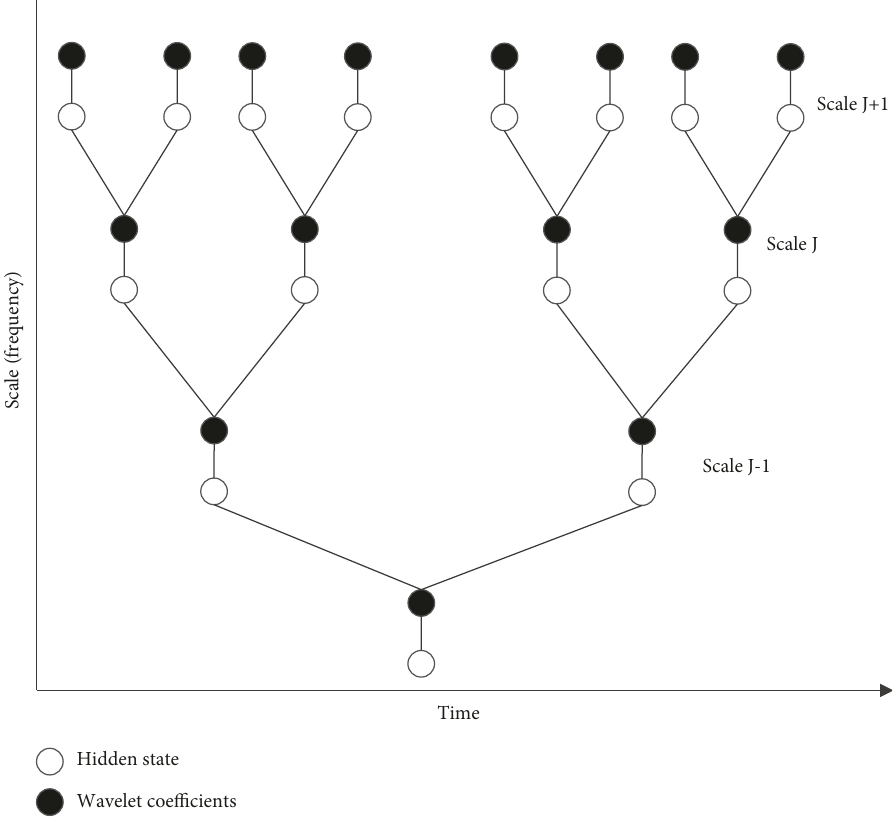
Figure 3: Hidden Markov tree model structure in wavelet